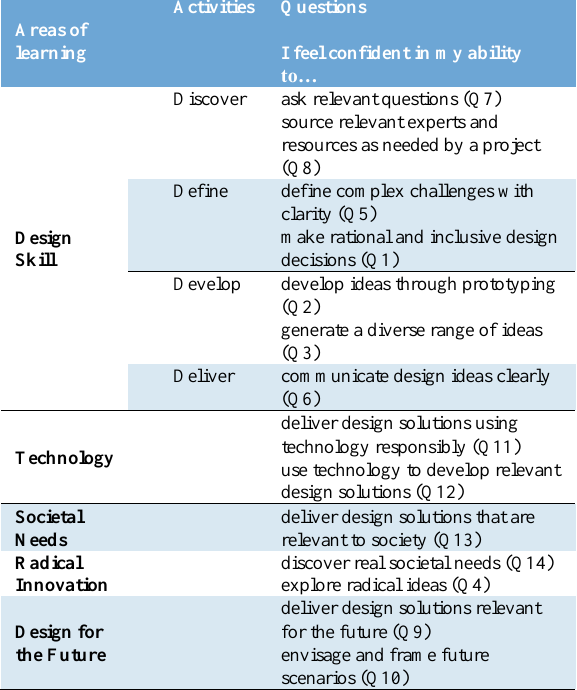
Table 2 . CBI A 3 survey questions mapped to design skills and four domain